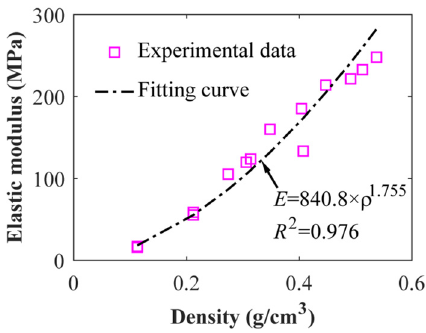
Figure 11: The variation laws of the elastic modulus ( E ) of TFPU grouting materials with density. Figure 12 and Figure S4 present the comparison between the experimental stress – strain curves of TFPU